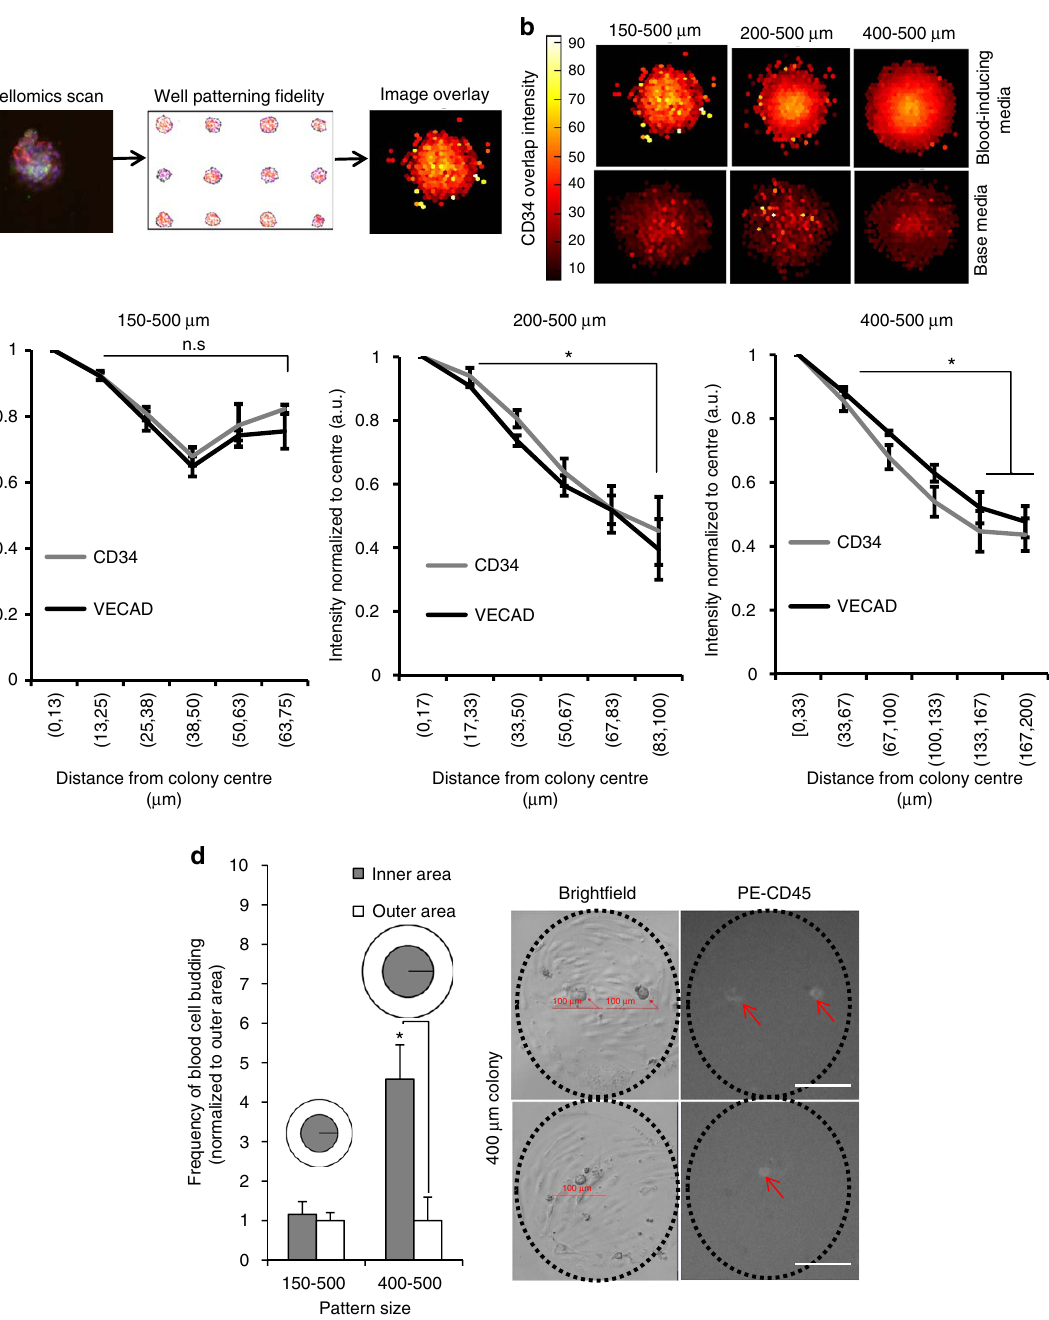
Figure 4 | Spatial control of day 8 hPSC-derived HE via micropatterning influences intra-colony organization of CD34 and VECAD expression and blood cell emergence during haematopoietic differentiation. ( a ) Overview for generating CD34 þ and VECAD þ distribution overlay. Fluorescent images of colonies in unique treatments are assessed for patterning fidelity and then single-cell data are consolidated to generate superimposed images. ( b ) Representative CD34 þ expression overlays in increasing colony size in haematopoietic-inducing or base medium (as outlined in Methods). ( c ) Quantification of CD34 and VECAD expression in increasing colony size from the centroid to the edge, n ¼ 3. ( d ) Live imaging analysis comparing budded CD45 þ blood cell frequencies between the inner and outer colony areas of 150 and 400 m m colonies (left), n ¼ 3. Data are presented as mean ± s.e.m. Treatments joined by asterisks are significantly different ( P r 0.05, Student’s t -test). Scale bar, 100 m m. See also Supplementary Movies 1 and